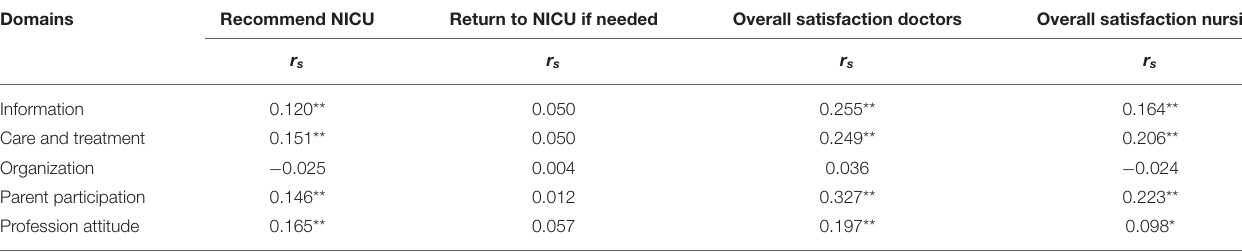
TABLE 3 | Congruent validity domains of EMPATHIC-30-China with 4 general satisfaction items.